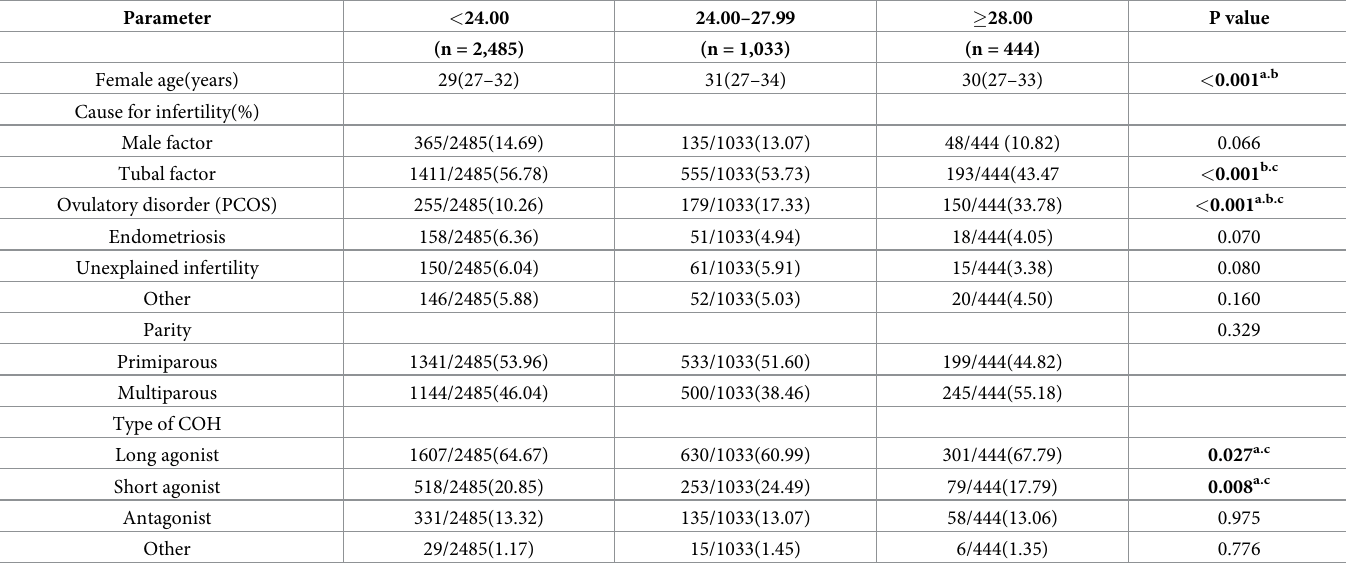
Table 1. Baseline characteristics of women achieving singleton pregnancies by BMI